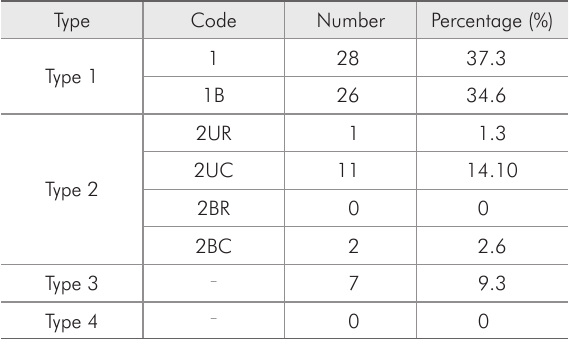
Table 2 - Classification of bifid mandibular canals found in the sample analyzed ( % ), according to Langlais et al.